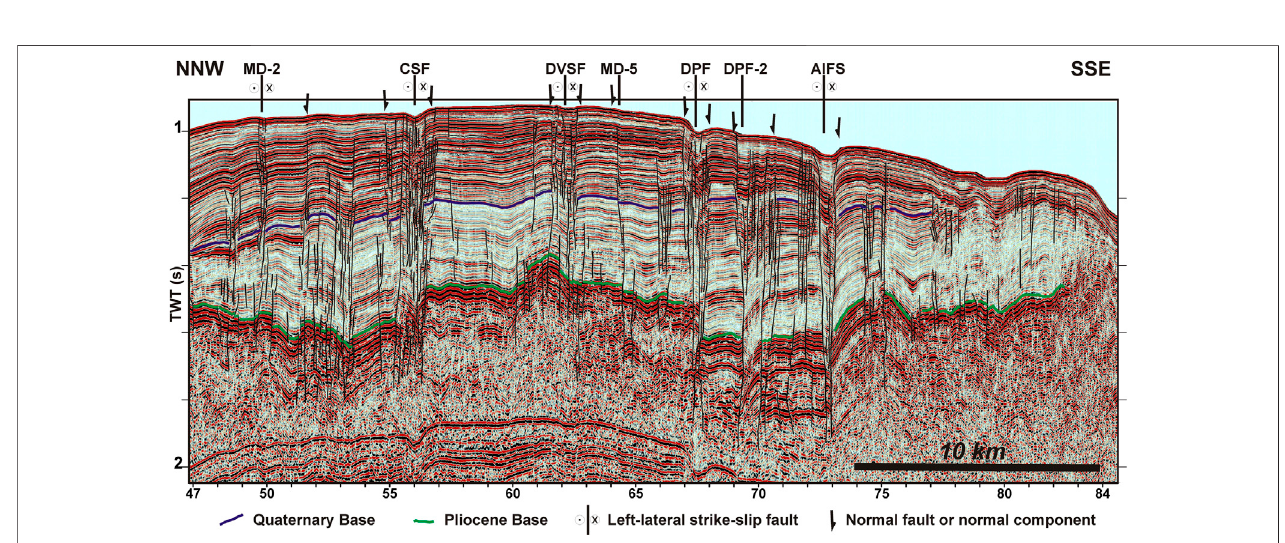
FIGURE 8 | High-resolution multichannel seismic pro fi les crossing the set of NNW-SSE left-lateral strike-slip faults that composes the Motril-Djibouti Marginal Plateau (MDF): MD-2 and MD-5 secondary fault zones, CSF: Calahonda Sound Fault, DVSF: Djibouti Ville Seamount Fault; DPF and DPF-2: Djibouti Passage Fault and AIFS: Al Idrissi Fault System. See location in Figures 2 , 7